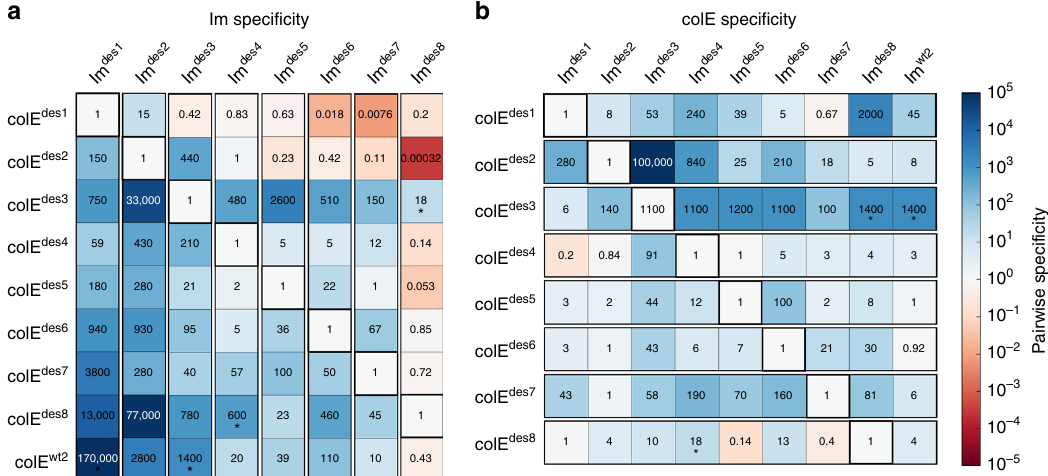
the user ’ s choice). We anticipate that Af fi Lib may in some cases eliminate the laborious iterations of af fi nity maturation or deep mutational scanning that are a requirement in most current binder design and engineering studies 54,55 .